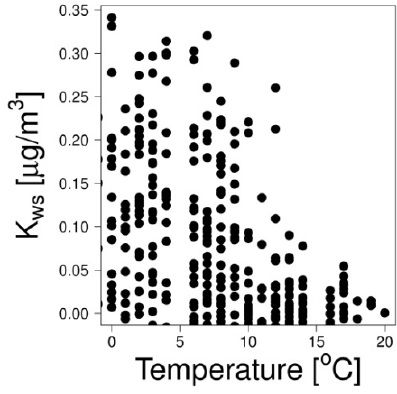
Fig. 5. Variation of K ws with temperature at EROS